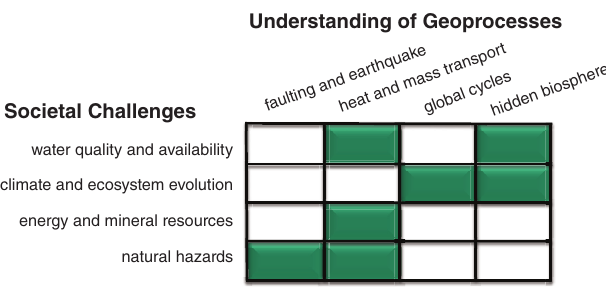
Figure 2. Matrix structure for ICDP ’ s new science plan showing in green where Societal Challenges topics meet the themes of Understanding of